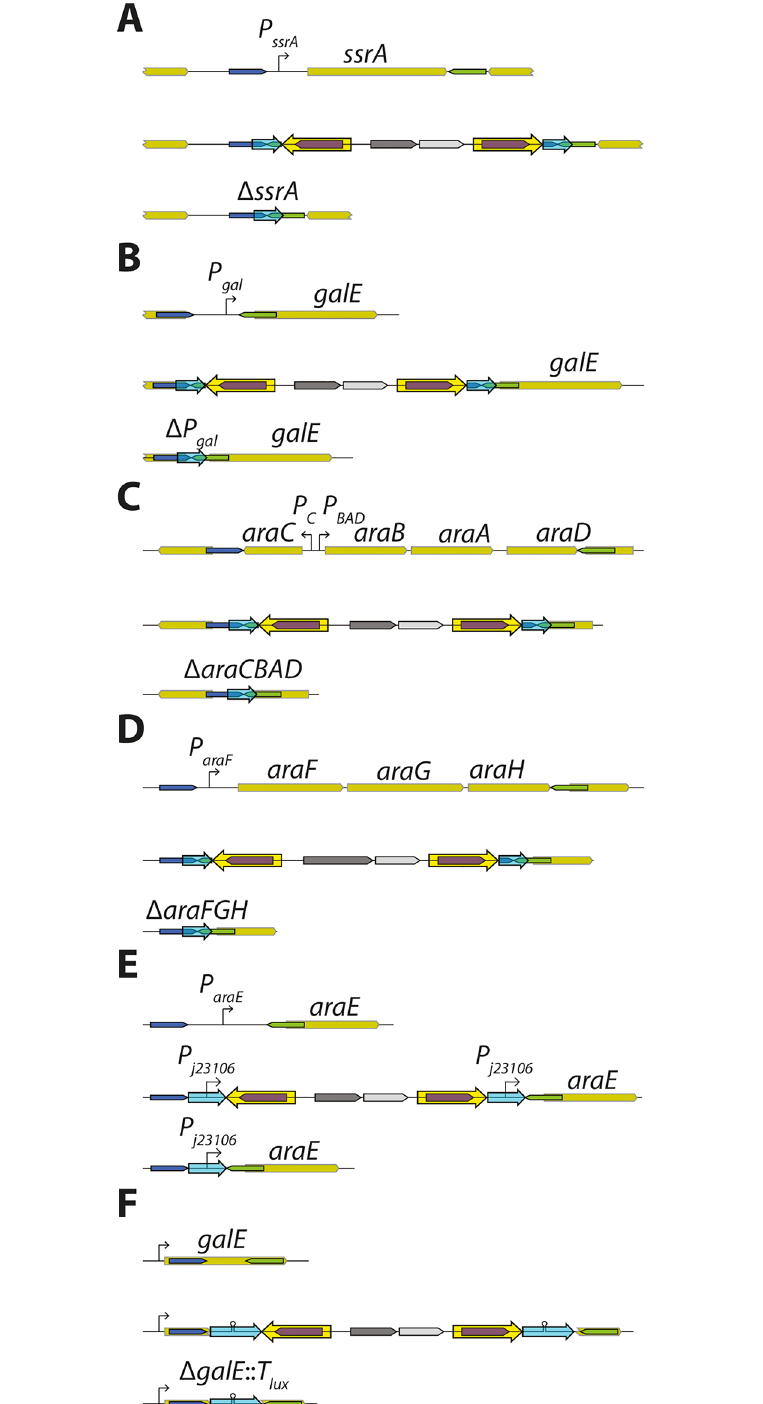
Fig 5. Use of DIRex to generate deletions and replacements. Dark blue and green areas indicatethe recombinogenic homology arms and light blue arrows indicate the DRs used for excision. For each construct, the top line shows the wild-typearrangement, the middle line the DIRex intermediate and the bottom line the final mutant. (A) Deletionof the S . enterica ssrA gene, encoding tmRNA. (B) Deletionof the S . entericagal operonpromoterregion. (C) Deletionof the S . enterica araC , B , A and D genes. (D) Deletionof the E . coli araFGH operon, encodinga high affinity L-arabinose transporter. (E) Replacement of the native